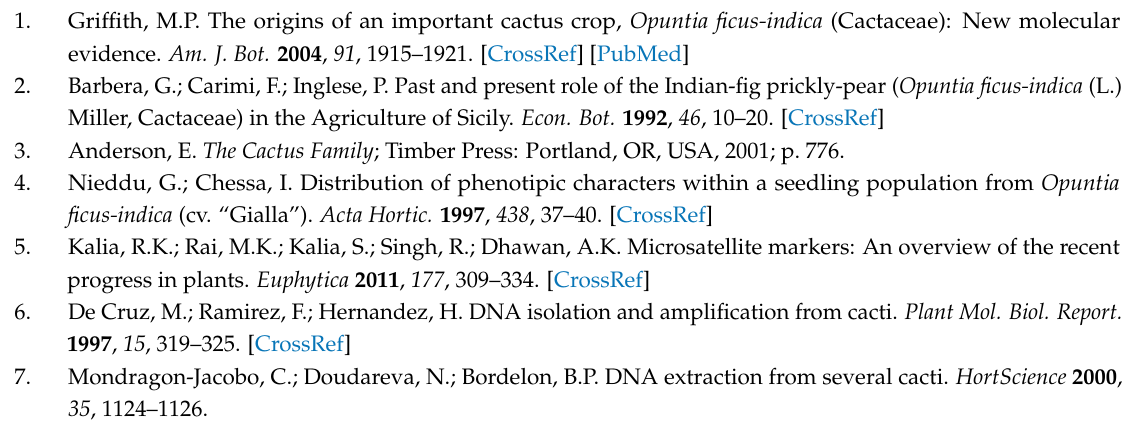
Table S1: Marker code, primer sequences, repeat unit, and annealing temperature of the six OPUNTIA and the nine OPUFIC primers used in this study, Table S2: Dice similarity coefficient for Opuntia spp. populations, Table S3: Analysis of molecular variance (AMOVA) of the Opuntia spp. accessions, considering the entire data set clustered in three groups (A, B and C), according to the PCoA analysis. SS = sum of squared deviation; df = degrees of freedom; and P = level of probability of obtaining a more extreme component estimate by chance